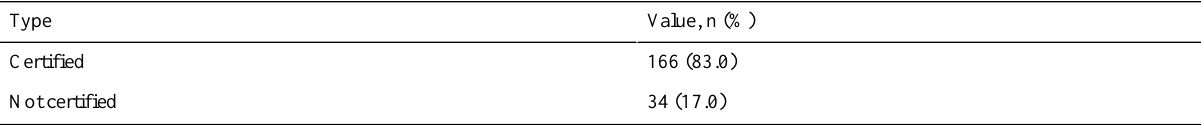
Table 8. The proportion of official hospital